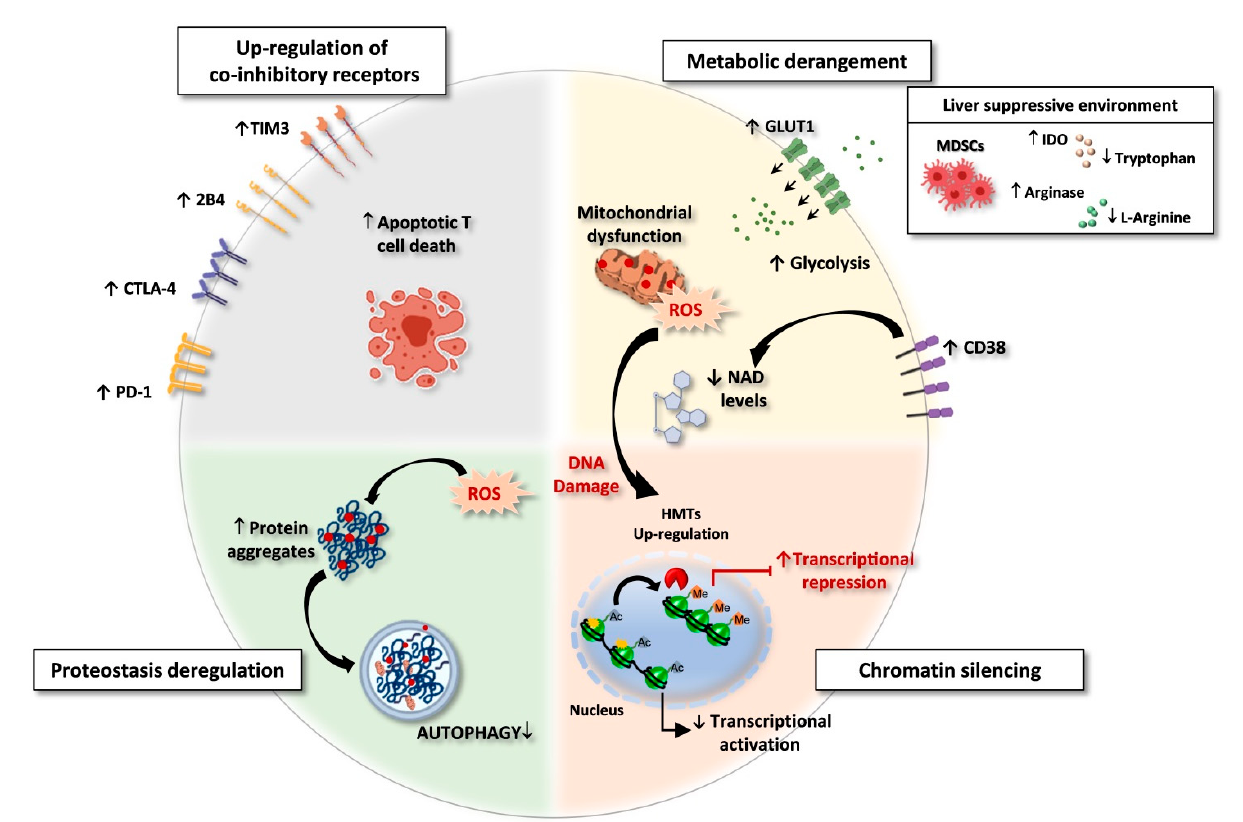
Figure 1. Exhausted CD8 T cells in HBV and HCV chronic infections. Features of exhausted T cells: (i) Upregulation of multiple co-inhibitory receptors; (ii) Metabolic derangement with depolarized mitochondria and ROS accumulation. A suppressive intrahepatic microenvironment enriched with amino acids degrading enzymes (e.g., arginase and IDO/TDO) causes reduction of amino acid availability. Lower respiratory capacity and amino acid starvation favor glycolysis as a compensatory mechanism, with upregulation of the glucose transporter GLUT-1. In addition, over-expression of CD38 can lead to increased intracellular NAD consumption, exacerbating mitochondrial dysfunction. (iii) Chromatin silencing due to histone methyltransferases (HMTs) upregulation and to the reduced availability of acetyl-CoA, as a consequence of low NAD levels, fundamental co-factor for histone acetylation. (iv) Proteostasis deregulation. High ROS levels lead to oxidation and damage of proteins and cell organelles. Exhausted CD8 T cells express a deregulated proteostasis with lower autophagy rates, leading to a defective clearance of aggregated proteins and damaged organelles. Created with BioRender.com, access on 1 September 2021.